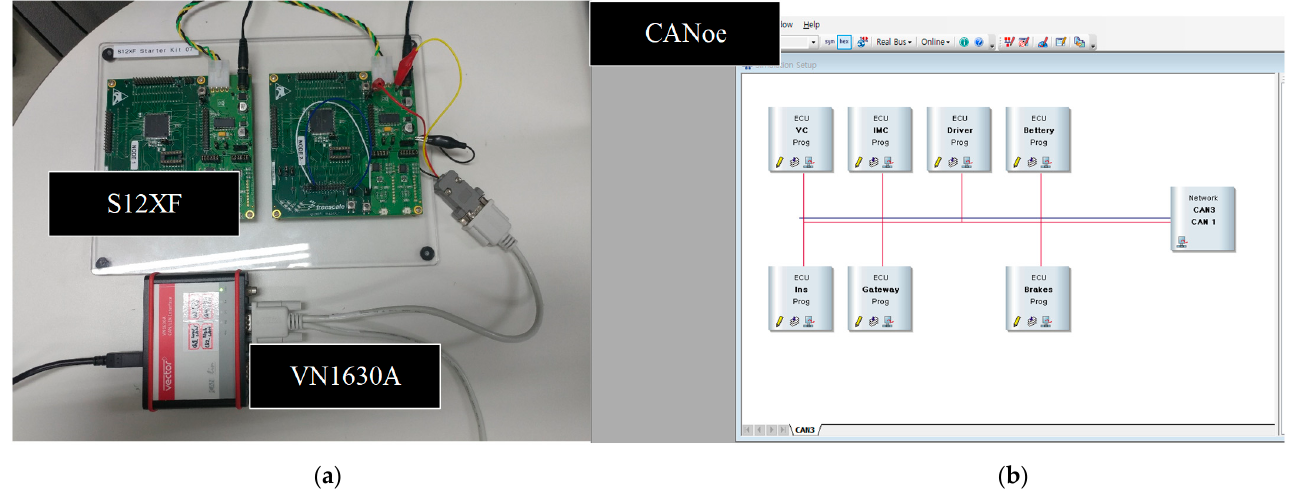
Figure 6. An experimental environment: ( a ) A snapshot of hardware components connected to CA- Noe; ( b ) a topology of the CAN network on CANoe. CANoe; ( b ) a topology of the CAN network on CANoe.